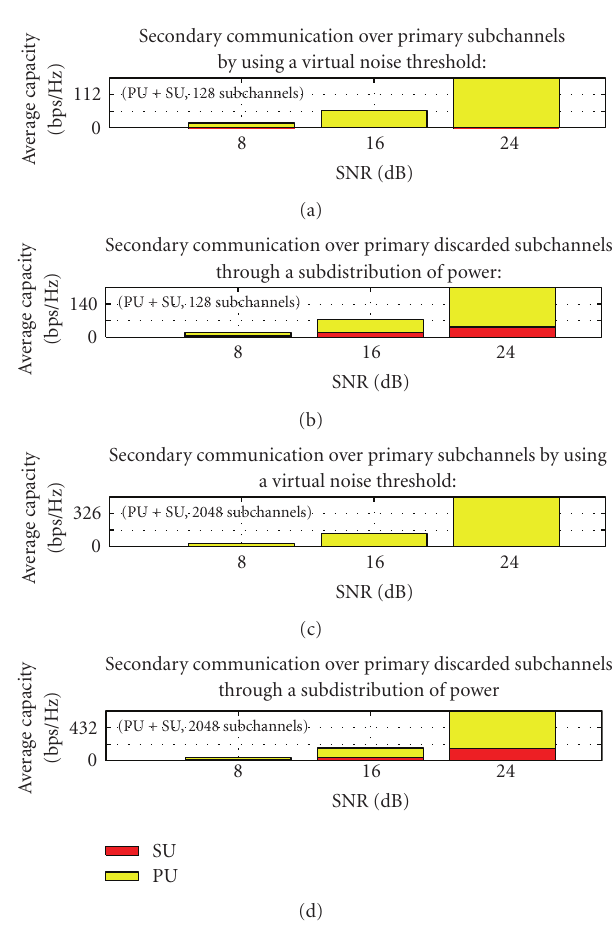
Figure 9: System’s performance comparison (128/2048 subchan- nels, P PU = 80% & P SU = 20%), SNR = 8 dB, 16dB, and